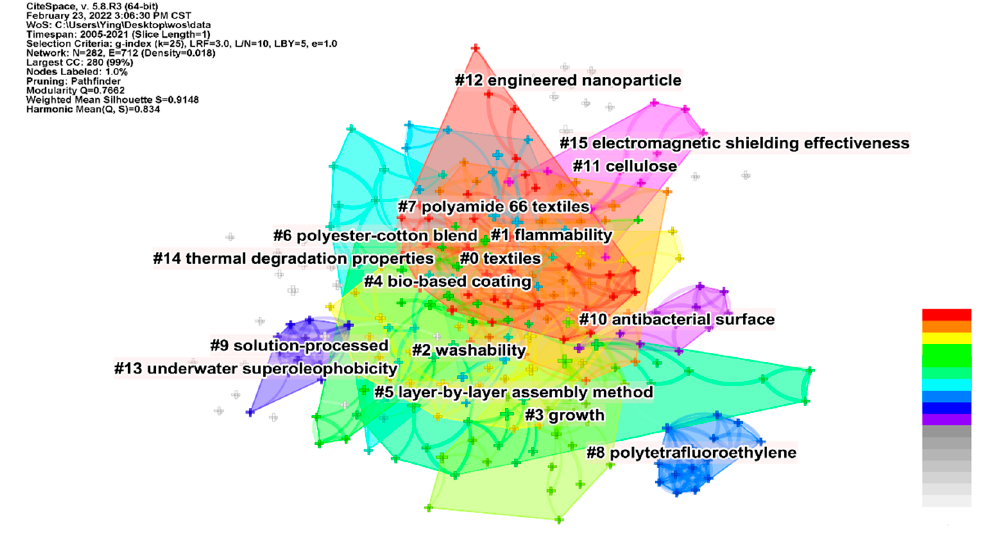
Figure 3. Co-occurring keywords-based knowledge clusters.